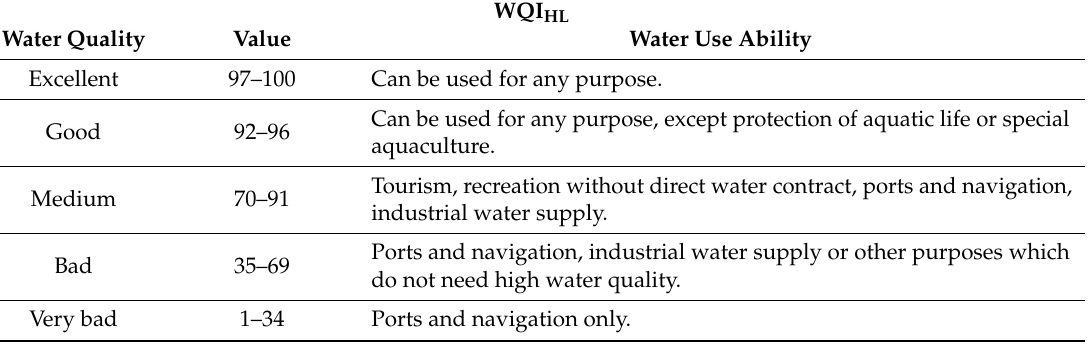
Table A5. Water quality classification and usages [32].